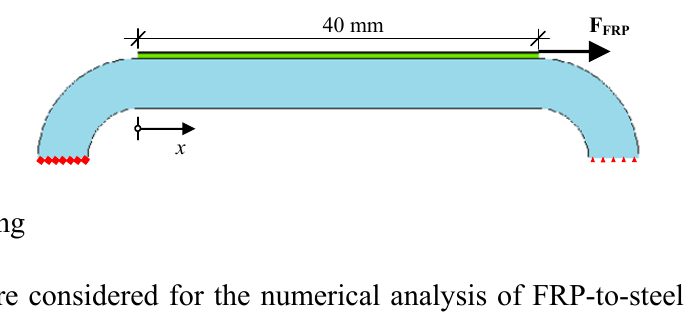
Figure 18. Basic numerical model with steel (light blue), adhesive (green), and CFRP